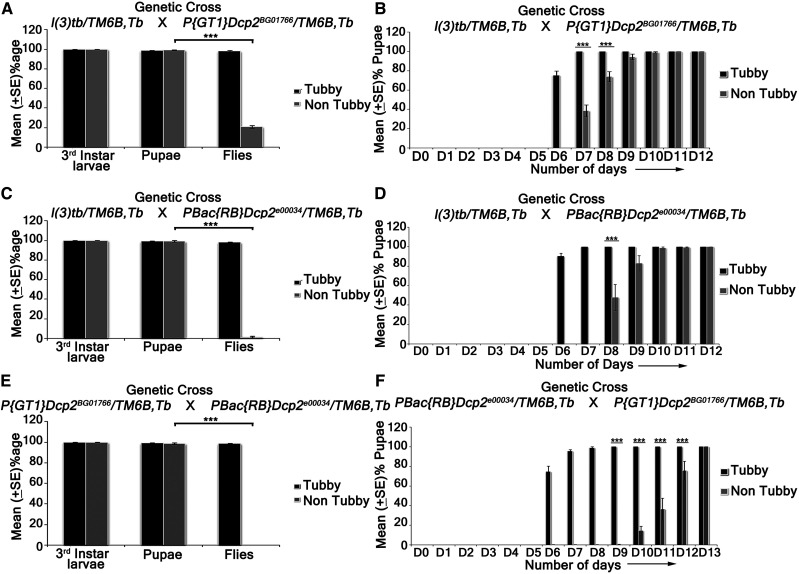
Trans-heterozygotes of DCP2 mutants and l(3)tb show developmental delay and larval/pupal lethality. Viability assay performed on various hetero-allelic combinations between alleles of DCP2 and the mutation in l(3)tb. Homozygous l(3)tb exhibited larval as well as pupal lethality. 69% of homozygous larvae pupated whereas no fly eclosed from the pupae. l(3)tb
trans-heterozygous with P{GT1}DCP2BG01766 showed only 18.4% fly eclosed (A). l(3)tb/ PBac{RB}DCP2e00034
trans-heterozygote (C) causes 100% lethality at pupal stage. Trans-allelic combination P{GT1}DCP2BG01766/ /PBac{RB}DCP2e00034 (E) also exhibited 100% pupal lethality. Developmental delay seen in trans-heterozygotes l(3)tb /P{GT1}DCP2BG01766 (B) and l(3)tb/PBac{RB}DCP2e00034 (D) as in homozygous l(3)tb. Progeny from heterozygous for both the alleles of DCP2 gene, PBac{RB}DCP2e00034 /P{GT1}DCP2BG01766 (F) also exhibited developmental delay. *** indicates P < 0.005.